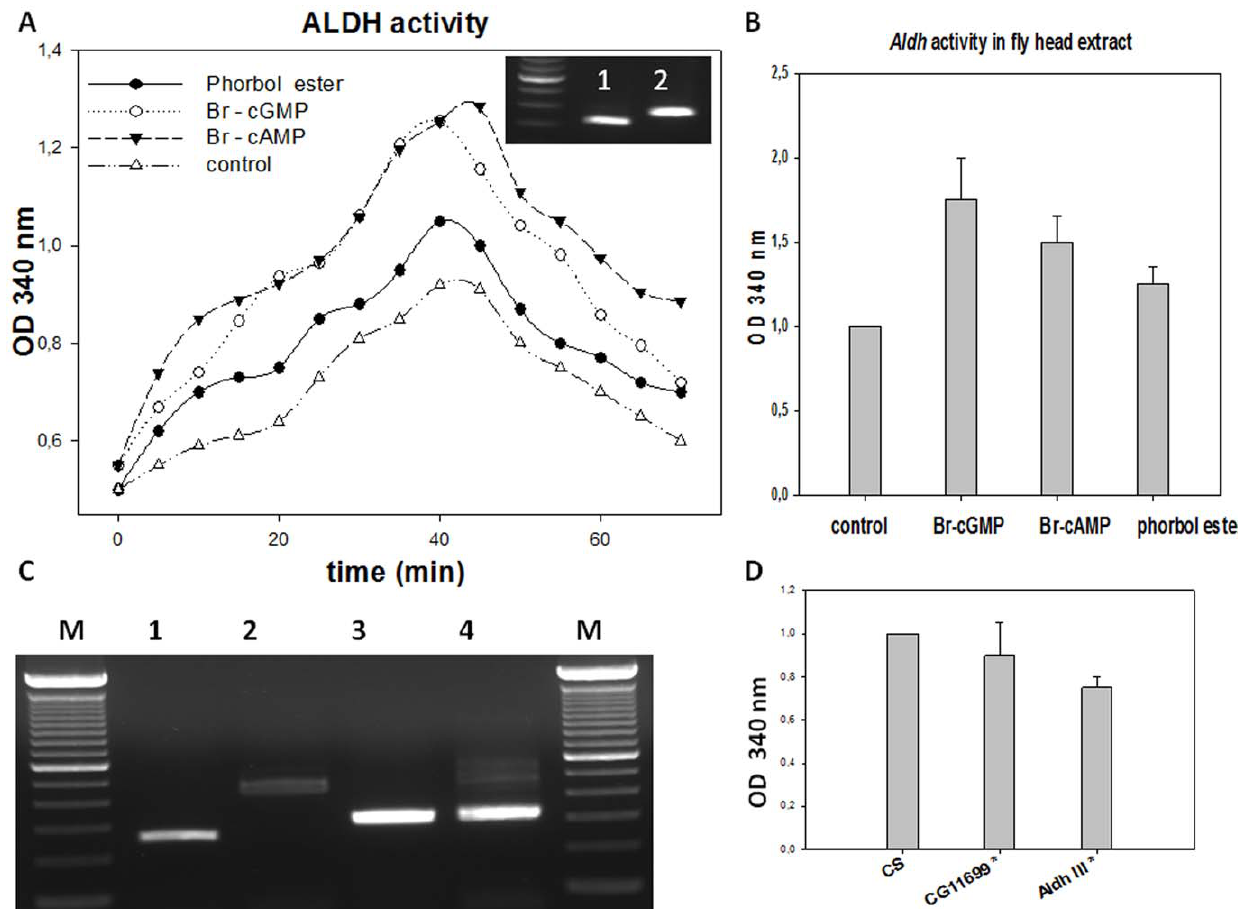
Figure 7. Aldh activity analysis of S2 cells after treatment with kinase activators. (A) Aldh activity using benzaldehyde as substrate was determined by measuring the spectrophotometric absorbance (OD) at 340 nm, which specifically quantifies the amount of reduced co-enzyme (NADH, NADPH). The main graph is representative of the Aldh activity from cells previously treated with 50 m M Br-cGMP, 50 m M Br-cAMP or 1 m M phorbol ester. These stable pharmacological agents activate the PKG (encoded by for ), PKA and PKC kinases, respectively. The curves are the means of three separate determinations. Inserted above the curves, is the PCR analysis of the transcript of CG11699 (1) in the sub-clone of S2 cells used in this series of experiments and of its genomic fragment (2) (see figure S4 for the primers). To summarize, Br-cGMP treatment gave 1.3 versus 0.9 for the control. (B) The graph represents the comparative mean + / 2 S.E. of five determinations of the total activity in membranes of the adult CS heads. The pharmacological agents plus ATP (50 m M) and Mg ++ (1 mM) had been previously incubated with the crude extract prior to the enzymatic determinations. The Drosophila head membrane extracts gave 1.8 + / 2 0.25 for Br-cGMP treatment versus 1.5 + / 2 0.15 for Br-cAMP and 1.2 + / 2 0.1 for phorbol ester. Control versus Br-cGMP Student’s t -test: p , 0.005. (C) PCR analysis using total RNA from S2 cells used in this series of experiment was performed to determine the presence of Aldh-III transcripts. 100 bp markers (Invitrogen) were used (the most intense band is at 600 bp). Lane 1, Aldh1 / Aldh5 corresponding to transcripts A–H (240 bp); lane 2, Aldh2 / Aldh5 corresponding to transcripts C, G and H (430 bp); lane 3, Aldh3 / Aldh6 corresponding to transcripts A and C (300 bp); lane 4, Aldh4/Aldh6 corresponding to transcripts A, C, and H (300 bp). See figure S4 for the design and the location of the primers. (D) The comparative dosage of Aldh activity was also determined with 100 m g of total membrane proteins from extracts of CS (used as control), CG11699 * and Aldh-III * mutant adult flies (five days old) using the same protocol. Bars represent the mean of three separate experiments + / 2